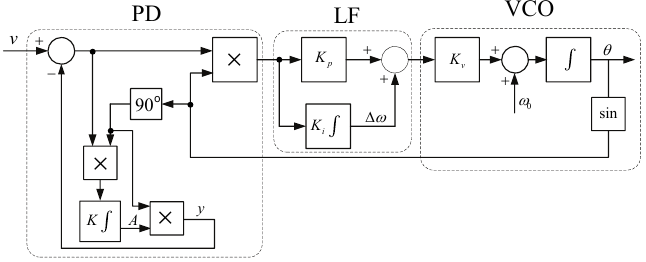
Figure 23. Single phase EPLL.